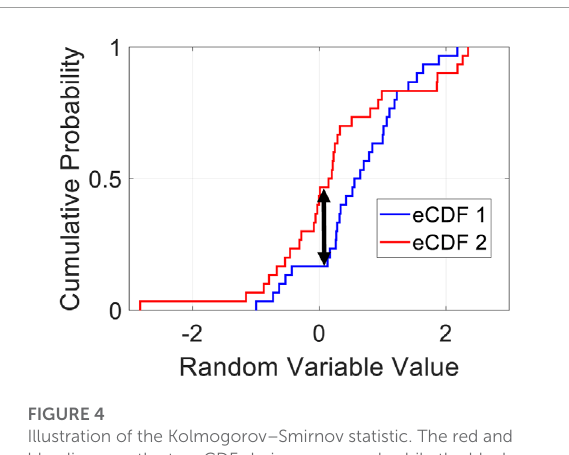
FIGURE 4 Illustration of the Kolmogorov–Smirnov statistic. The red and blue lines are the two CDFs being compared, while the black arrow is a measurement of the largest distance between the two distributions. It is commonly known as the K-S statistic Massey (1951), but is also referred to as the D-value (distance value) in the present